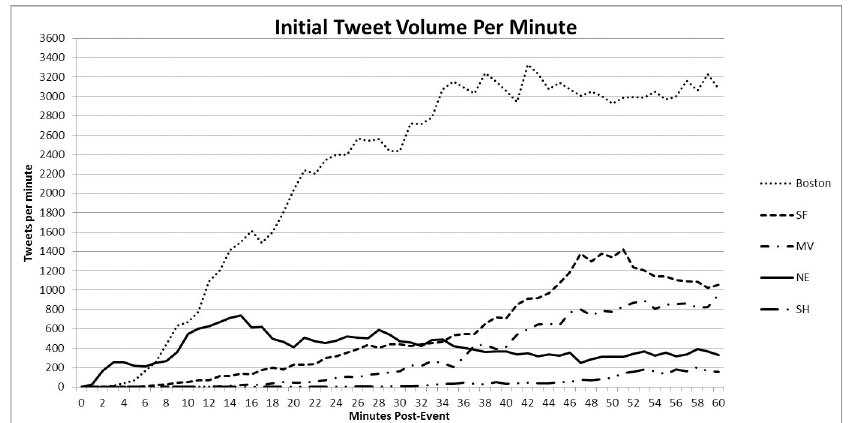
Fig 2. Tweet volume per minute in the first 60 minutes following the official event time. BB: Boston Bombing; SF: San Francisco Air Plane Crash; NE: Napa Earthquake; MV: MaryvilleSchoolShooting;SH: Sandy Hook Elementary